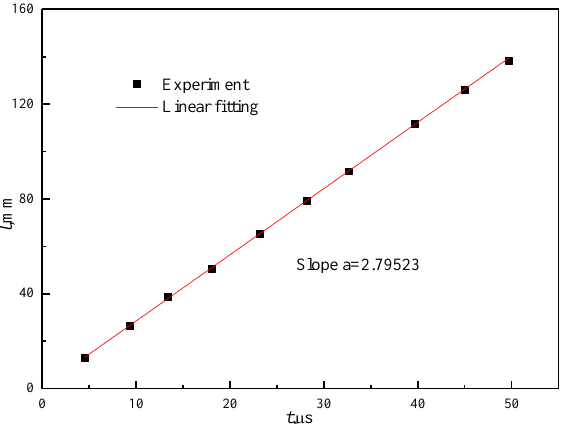
Figure 3. Linear fitting curve of the experimental results, the slope represents the velocity of surface wave propagation in the TC4 base material.